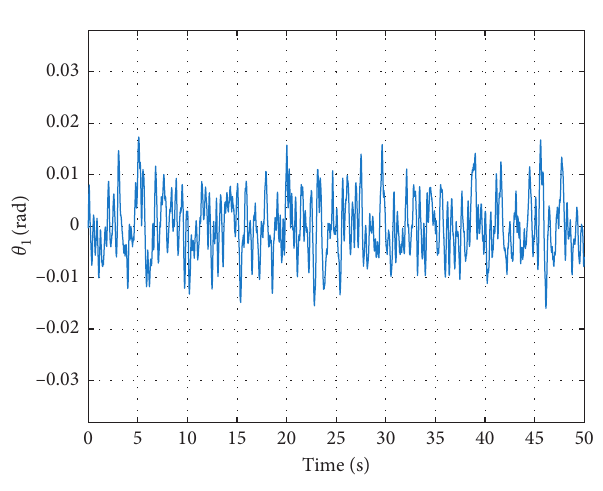
Figure 6: Swing rod 1 angle.